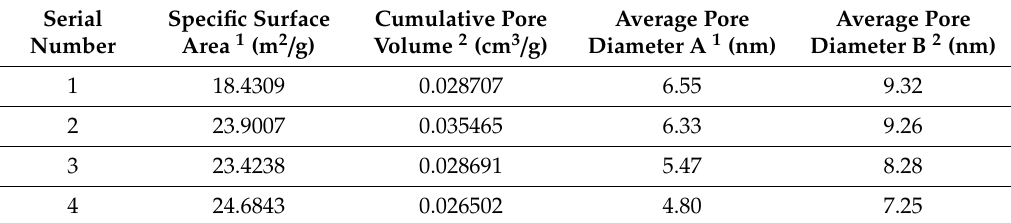
Table 2. Specific surface area and pore size distribution of the shale particle